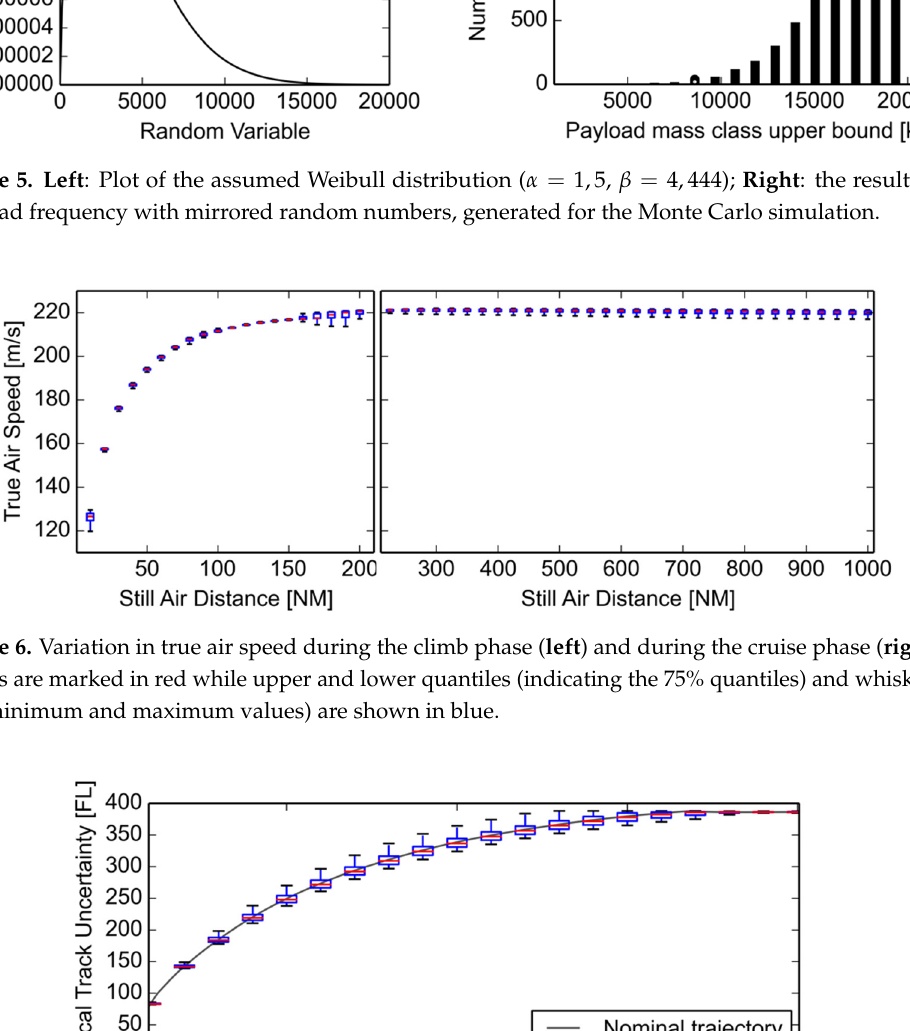
Figure 7. Climb profile of the nominal trajectory (grey) akin to the observed mean of VTU (red) of 11,000 simulation runs with Weibull distributed ATOM (blue).